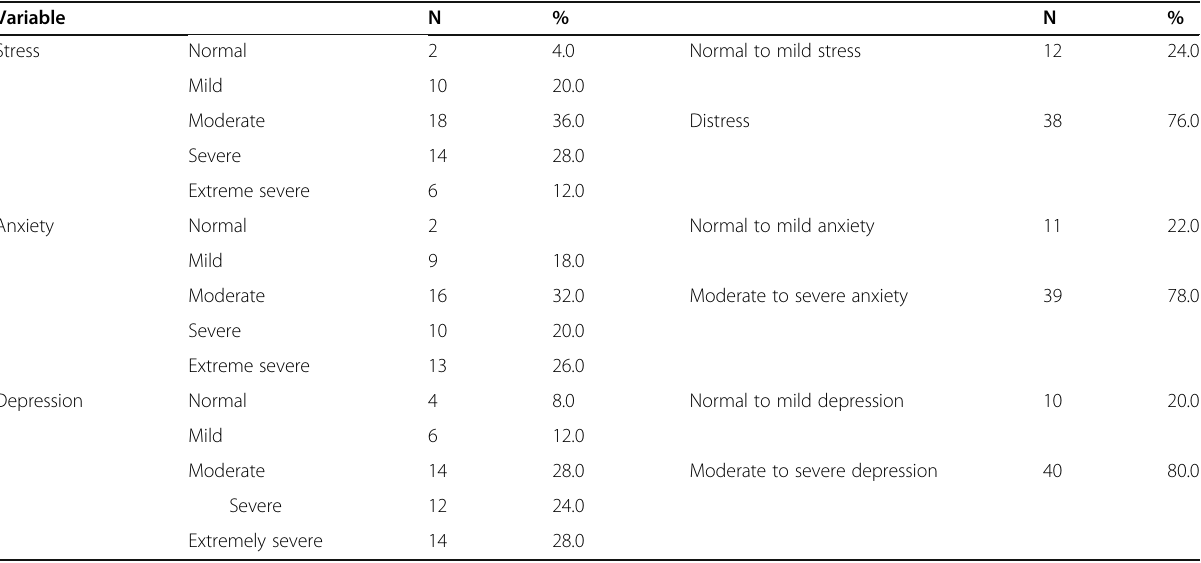
Table 2 Stress, anxiety, and depression among patients Variable N N